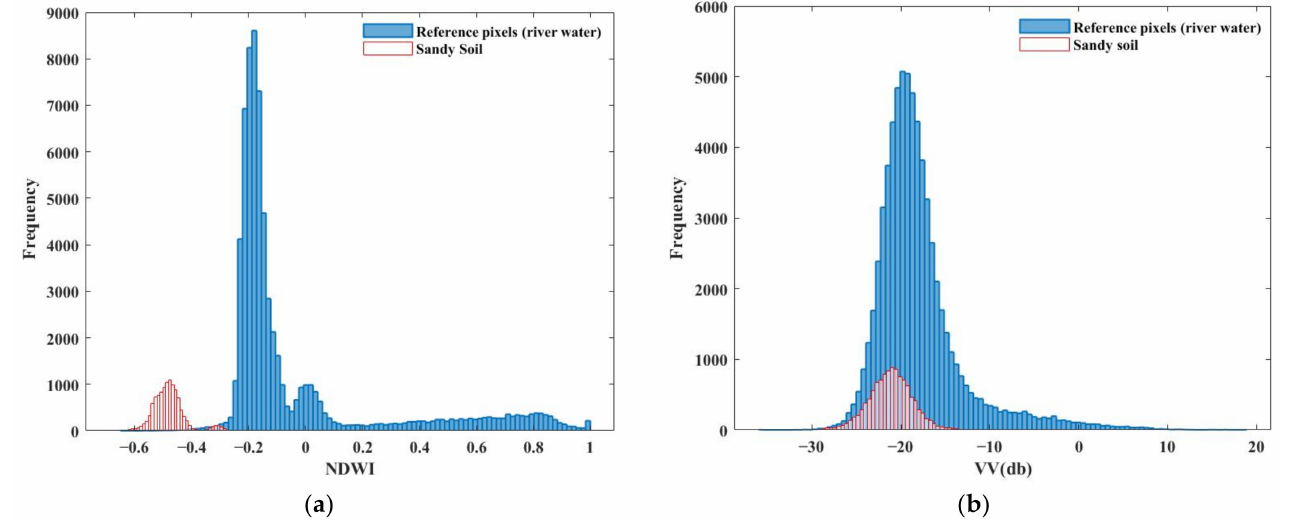
Figure 16. Signatures of sandy soils vs. reference water body observed during the 2020 flooding event: ( a ) NDWI from S2/MSI data and ( b ) VV backscatter (in dB) from S1 SAR